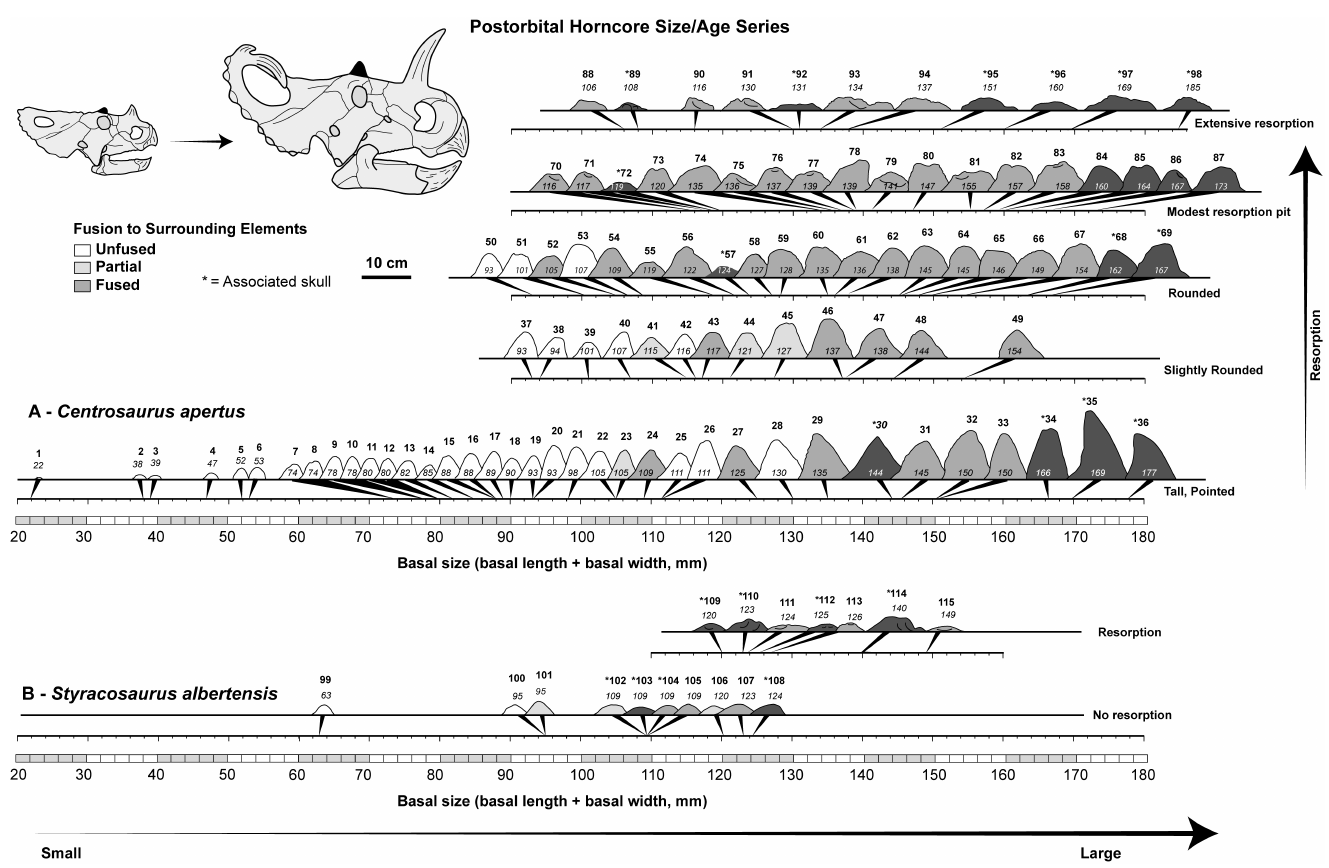
Figure 8. Size series of Centrosaurus apertus (A – upper) and Styracosaurus albertensis (B – lower) postorbital horncores in right lateral view. Specimens are arranged along the horizontal axis according to their size (basal length plus basal width), and separated vertically based on their degree of resorption. Although ordered based on size, the absolute position does not correlate directly with size due to spacing constraints. Numbers in italics indicate basal size metric, while numbers in bold refer to specimen numbers listed in Appendix